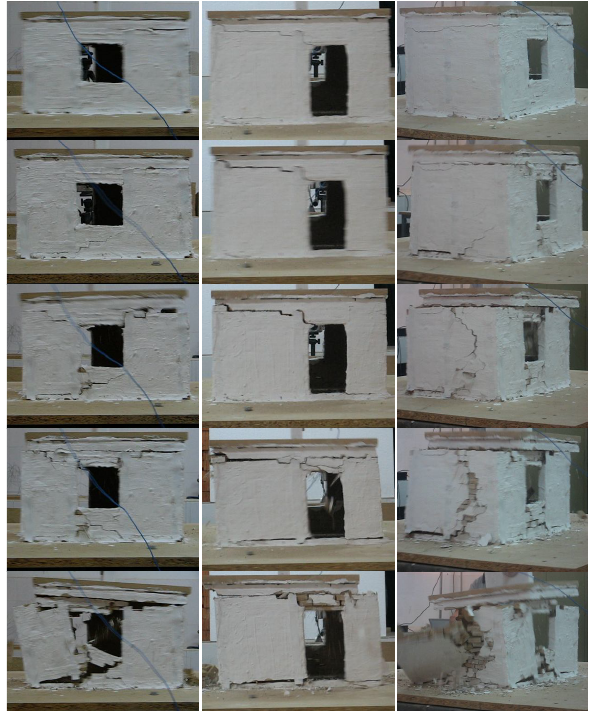
Fig. 17 Failure sequence of specimen SwSP 3.6 Steel wire mesh application (SM) Fig. 17. Failure sequence of specimen